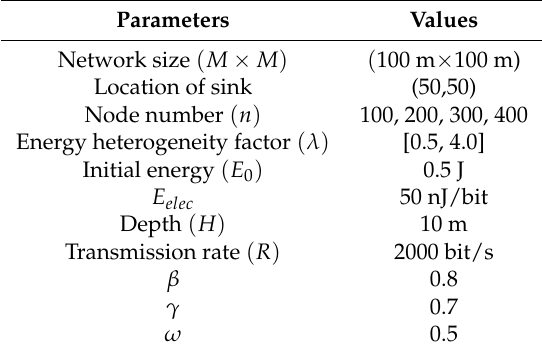
Table 1. Network simulation parameters